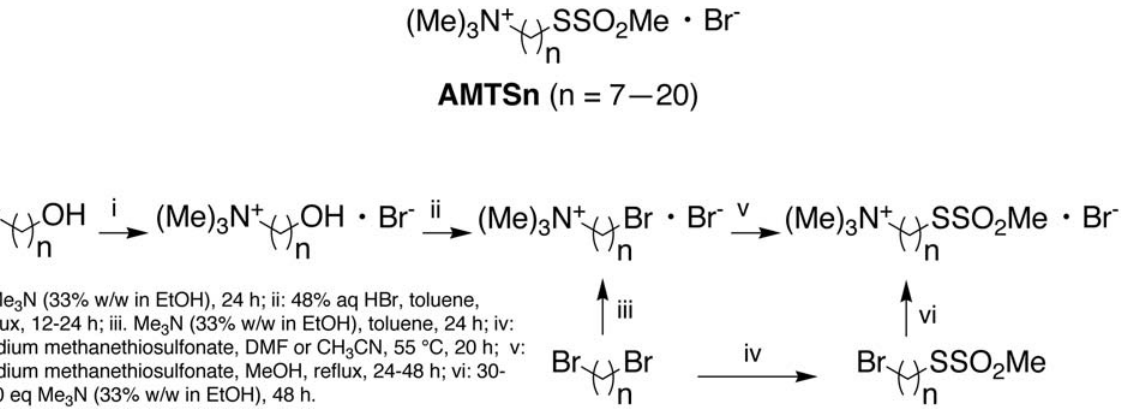
Figure 3. Chemical structures and synthetic schemes for AMTS7–AMTS20 as irreversible inhibitors of the greenbug acetylcholinesterase.